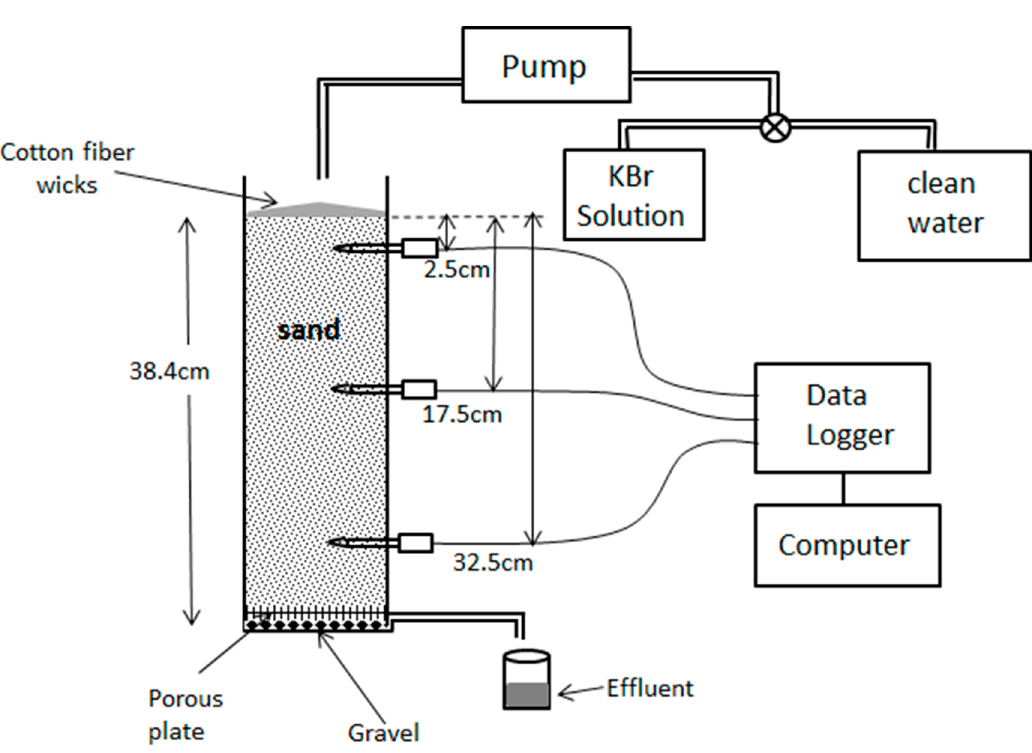
Figure 1. Schematic of the laboratory infiltration experimental setup.